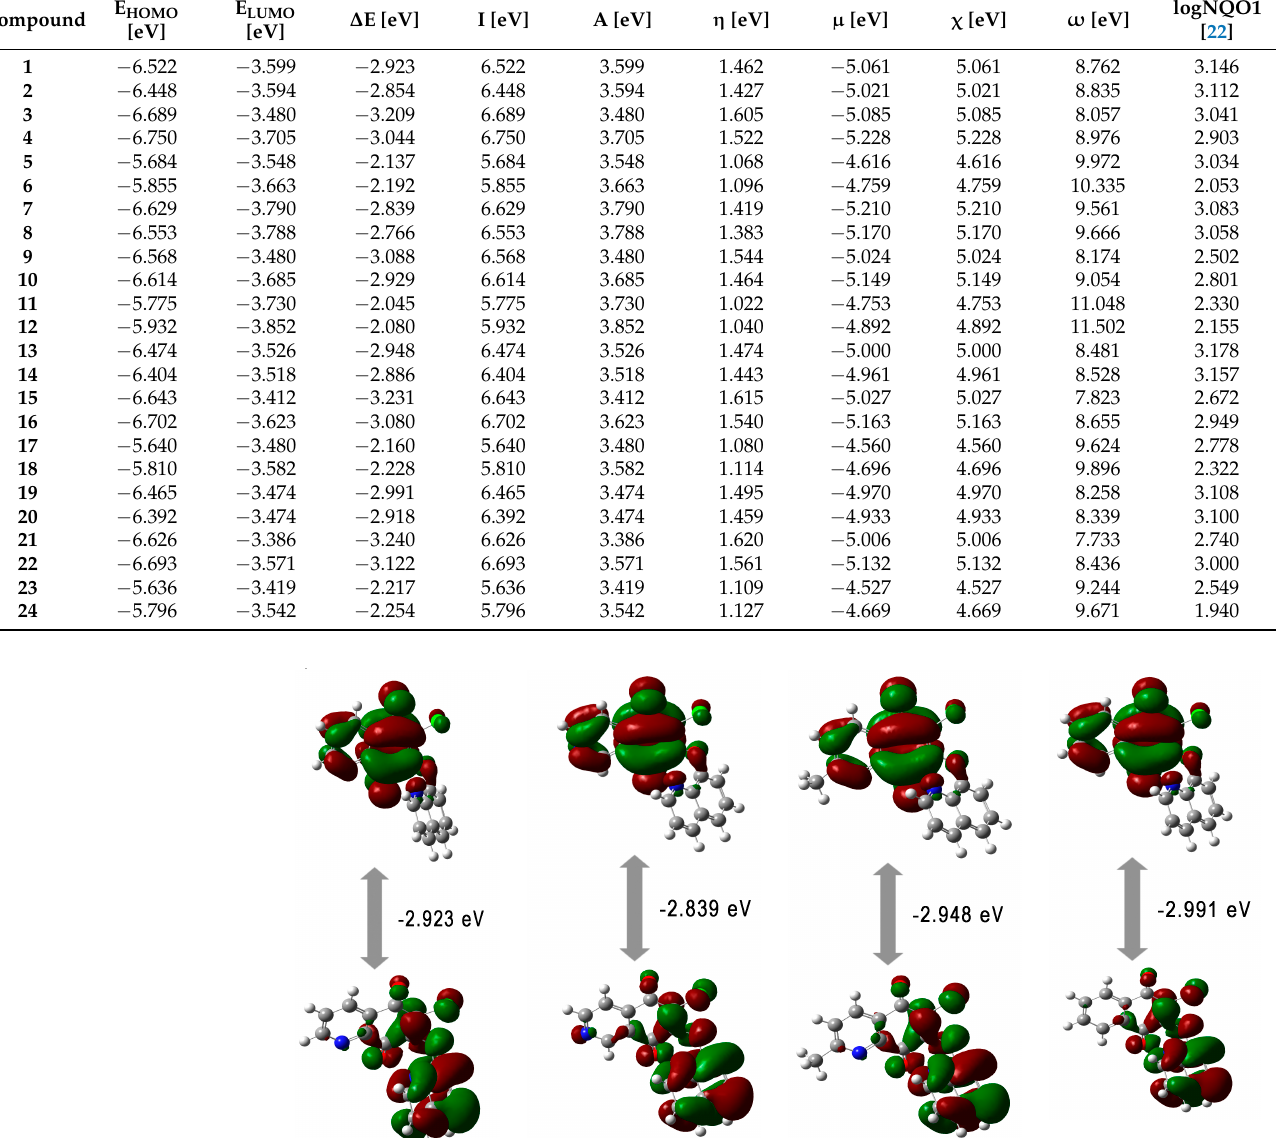
Table 9. Energy of the HOMO and LUMO orbitals, the global descriptor and enzymatic conversion rate of NQO1 for compounds 1 – 24 .